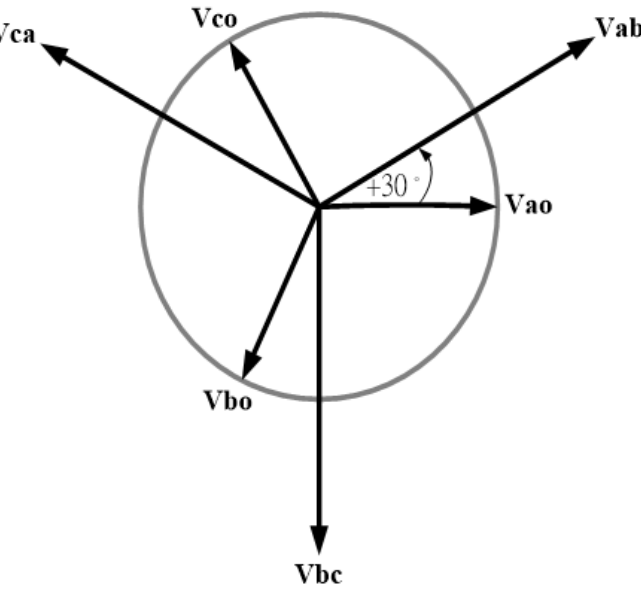
Figure 12. Balanced three − phase voltage phasor diagram of a switch without fault.